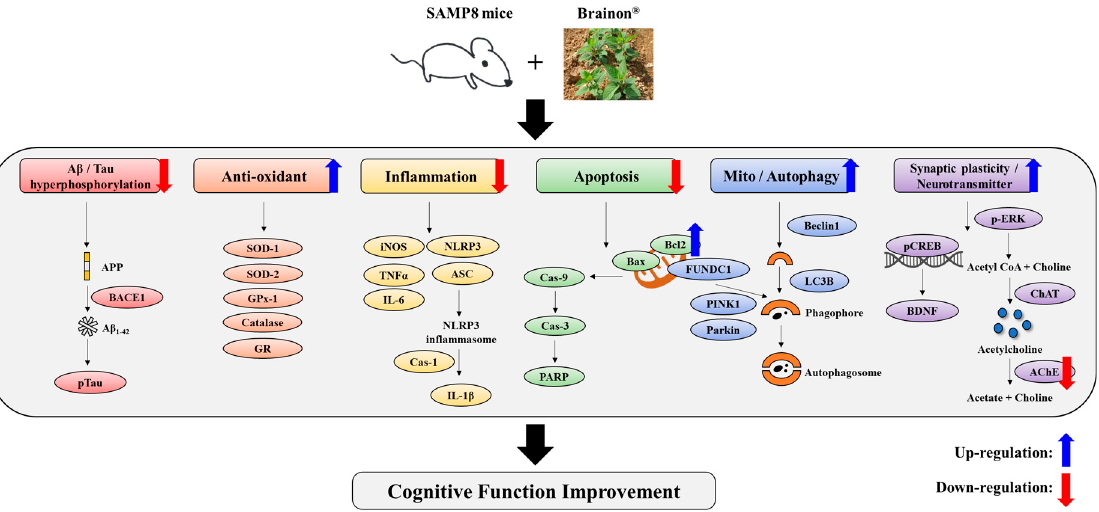
Figure 12. Schematic representation of obtained results and protective effects of Brainon ® to improve cognitive function in the SAMP8 mouse